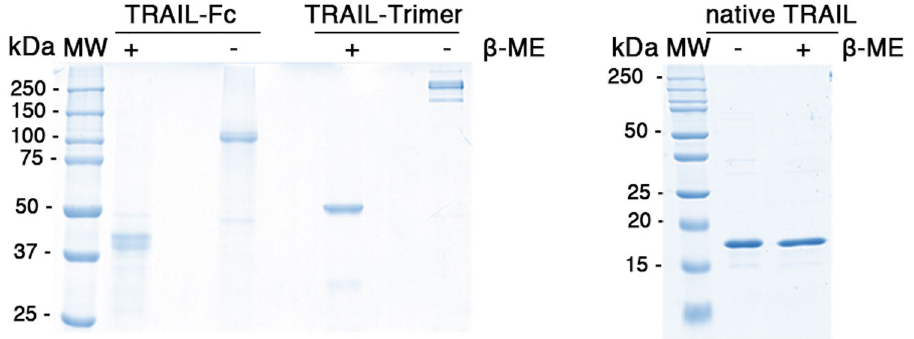
Figure 3. Purity evaluation of TRAIL-Trimer, TRAIL-Fc and native TRAIL. SDS-PAGE analysis of purified TRAIL-Trimer, TRAIL-Fc and native TRAIL under either non-reducing or reducing conditions. 2 µ g of purified protein was analyzed by 10% or 15% SDS-PAGE, respectively, and stained with Coomassie